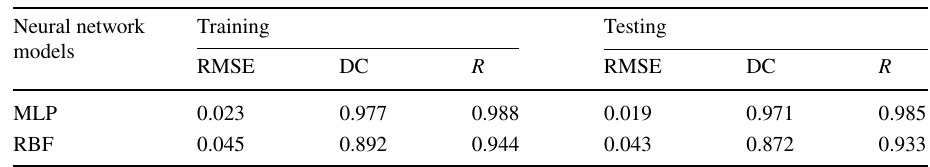
Neural network models